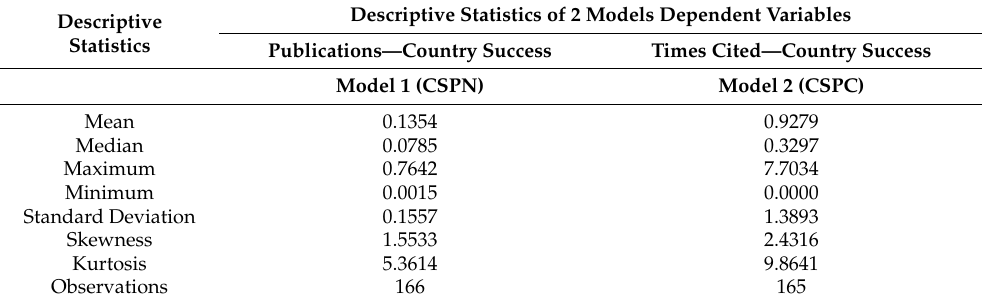
Table 4. Descriptive statistics for the dependent variables of two models.